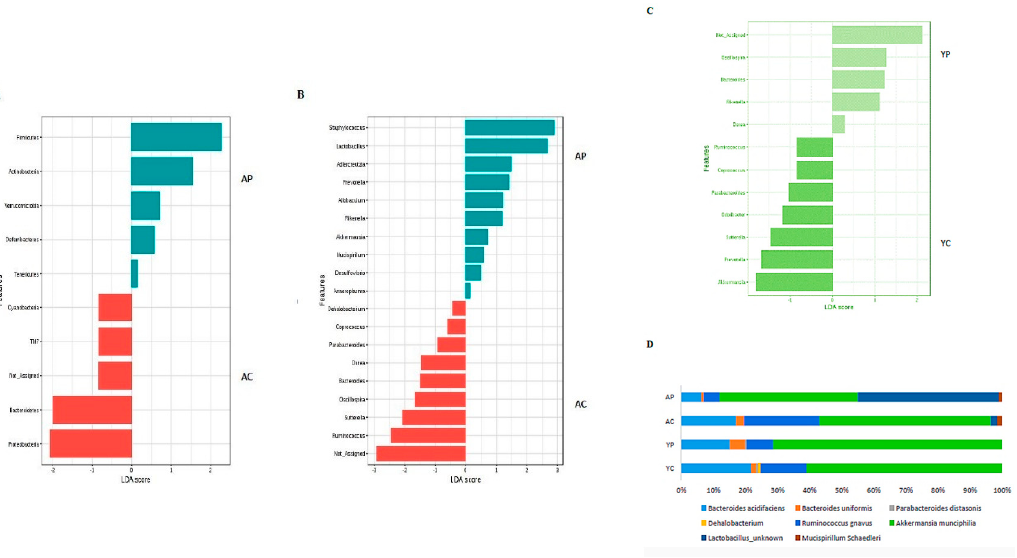
Figure 3. Comparative analysis with Linear Discriminant Analysis (LDA) Effect Size (LEfSe) scoring plot using Kruskal-Wallis rank sum test ( p = 0.01 and log LDA threshold cut-off value = 1.0). Aging groups at Phylum ( A ) and genus ( B ) level. Young groups at genus ( C ) level. Significant changes at species ( D ) level. (YC) Young control group, (YP) young probiotic group, (AC) aging control group, (AP) aging probiotic group.